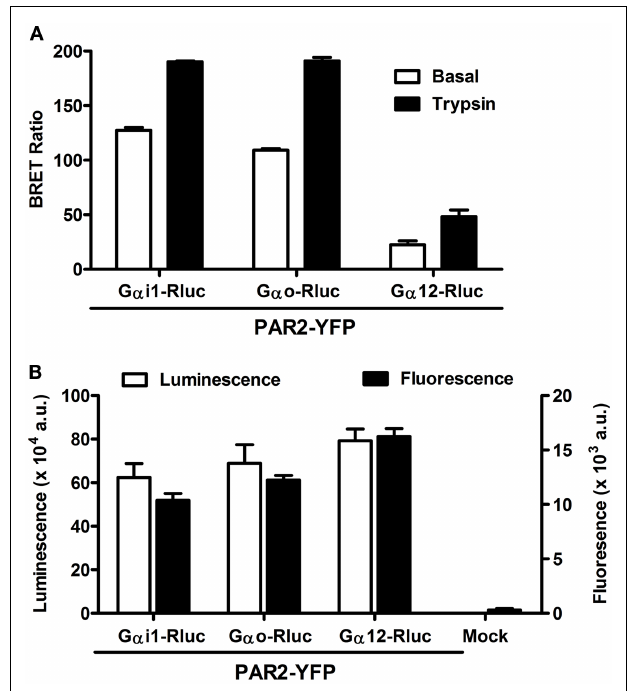
FIGURE 1 | Bioluminescence resonance energy transfer between PAR2 and G α proteins in live COS-7 cells . (A) BRET measurements in COS-7 cells co-expressing PAR2-YFP and either G α i1-Rluc, G α o-Rluc, or G α 12-Rluc in the absence ( (cid:3) ) and presence of stimulation with 100nM of trypsin ( (cid:4) ) for 2min (for G α i and G α o) or 30min for (G α 12). (B) Quantification of the luciferase (Rluc) activity ( (cid:3) ) andYFP fluorescence ( (cid:4) ) of BRET partners measured in BRET assay. Data are means ± SEM of three independent experiments performed in triplicate.